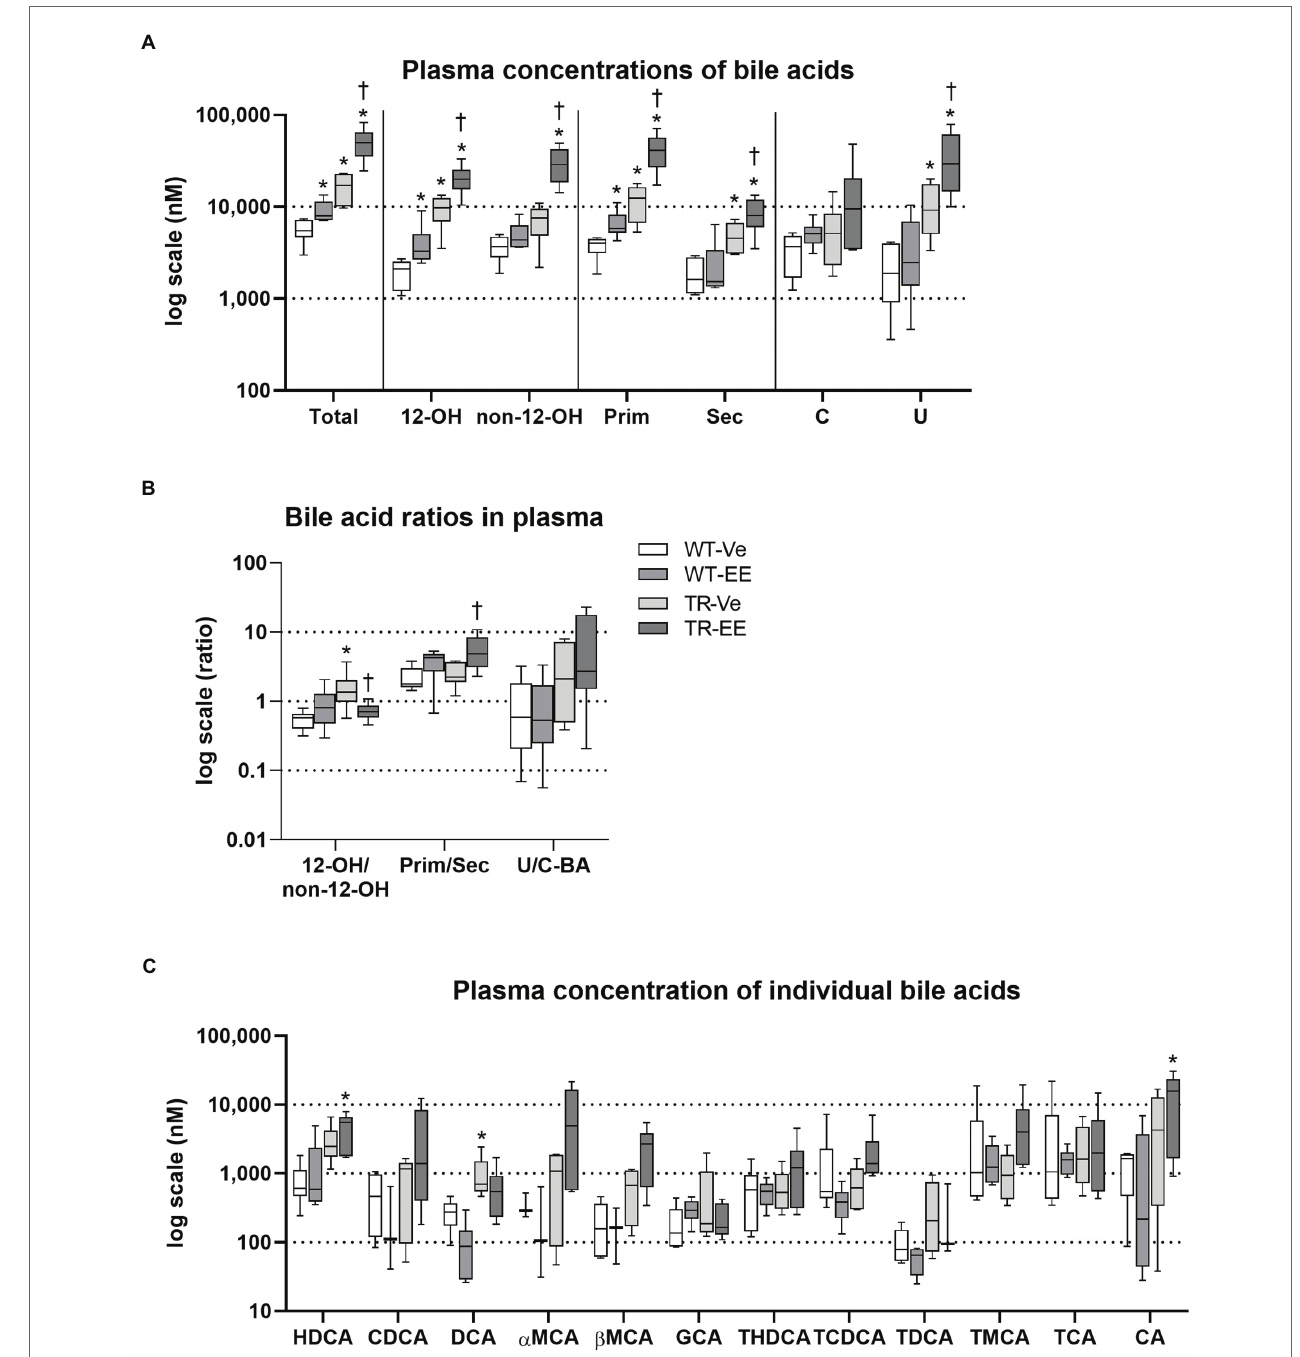
FIGURE 5 | Ethinylestradiol administration increased plasma concentrations of bile acids in WT and TR animals. Experimental groups: WT-Ve, WT rats receiving vehicle; WT-EE, WT rats receiving ethinylestradiol; TR-Ve, TR rats receiving vehicle; and TR-EE, TR rats receiving ethinylestradiol. (A) Types of bile acids measured in plasma. (B) Ratios of essential bile acid groups in plasma. (C) Concentrations of individual bile acids in the plasma. Data are presented as median values, with boxes and whiskers representing the interquartile range and 5th-95th percentiles, respectively. Significance: * p < 0.05 compared to vehicle-treated WT rats; † p < 0.05 compared to vehicle-treated TR group. BAs are presented as follows: 12-OH, non-12-OH, Prim, Sec, C, U, HDCA, CDCA, DCA, α MCA, β MCA, GCA, THDCA, TCDCA, TDCA, TMCA, TCA, and